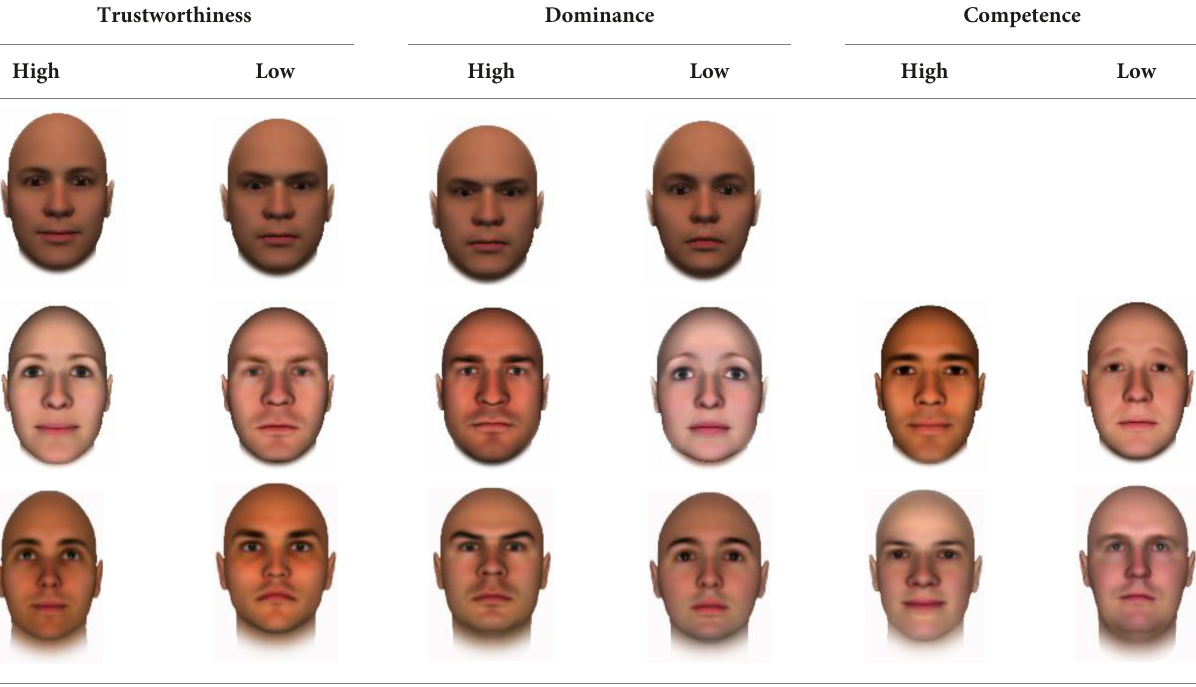
TABLE 1 Examples of the stimuli. Images in the upper and middle rows were used in Experiment